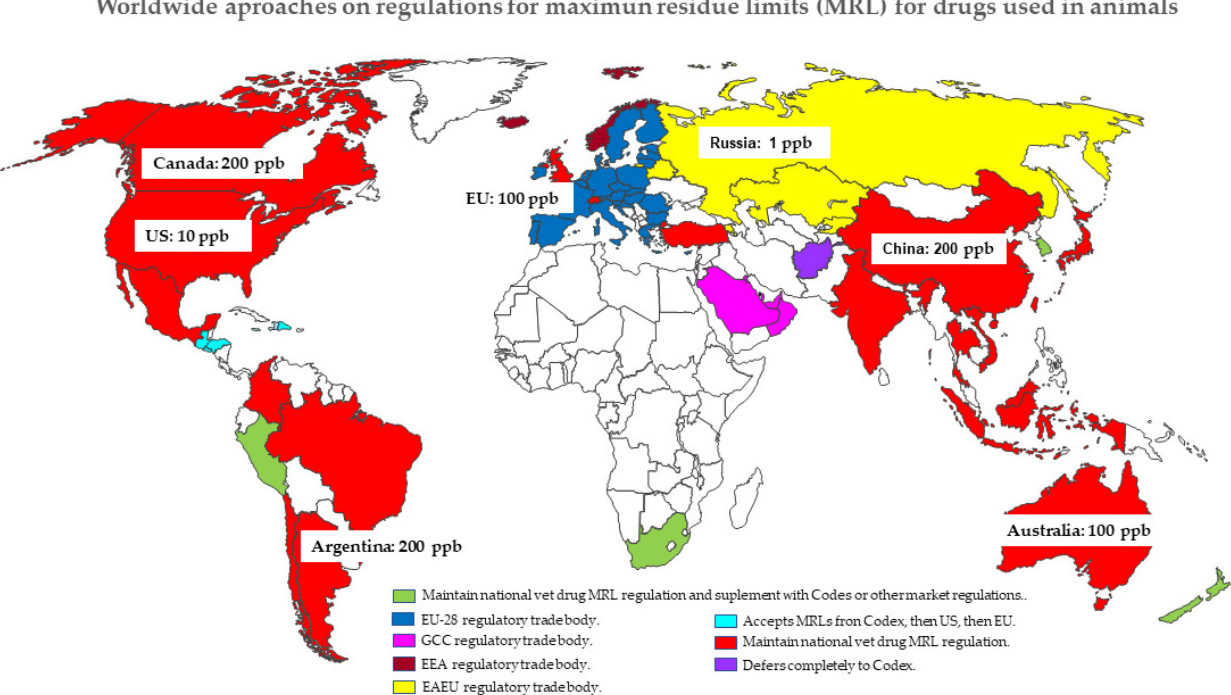
Figure 1. Countries’ classification according to the approaches taken for the regulation of maximum residue limits in food (MRLs/Tolerances) for veterinary drugs. The MRLs for oxytetracycline in cattle muscle adopted in some countries are shown as an example. GCC: Gulf Cooperation Council. EAEU: Eurasian Economic Union. EEA: European Economic Area. Data adapted from Stevenson, 2017 [29].